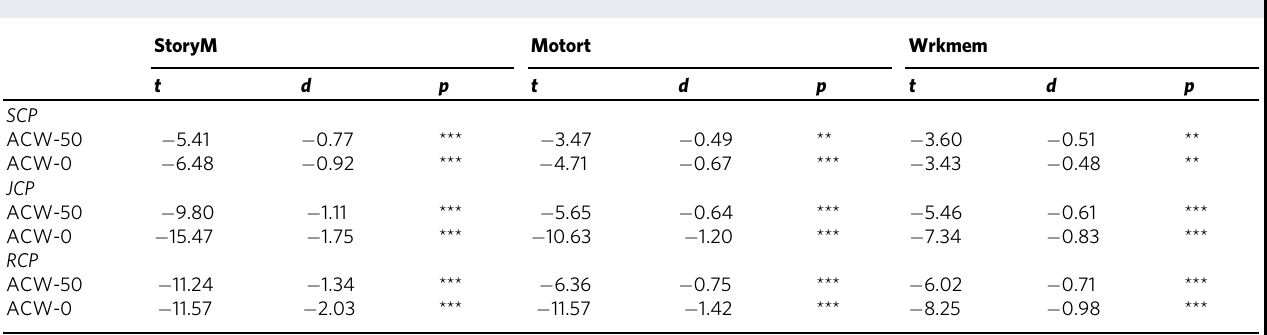
Table 1 Post-hoc results for periphery vs. core in different task conditions. StoryM